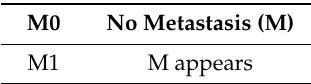
Table 4. Distant Metastasis